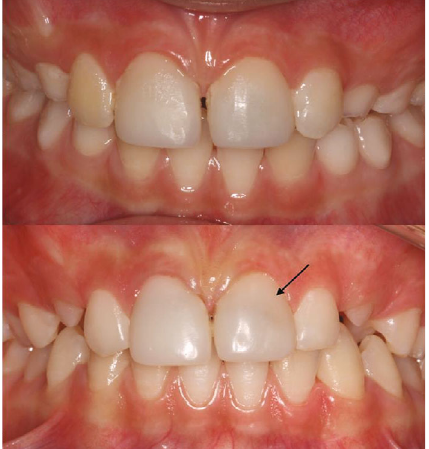
Figure 9: Follow-up after 6 months (up) and 3 years (down) with cervical discoloration in tooth no.